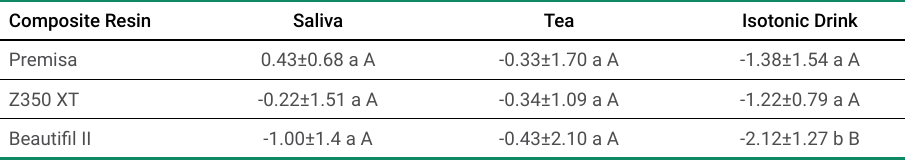
*Capital letter indicates statistical difference among columns. Lowercase indicates statistical difference among